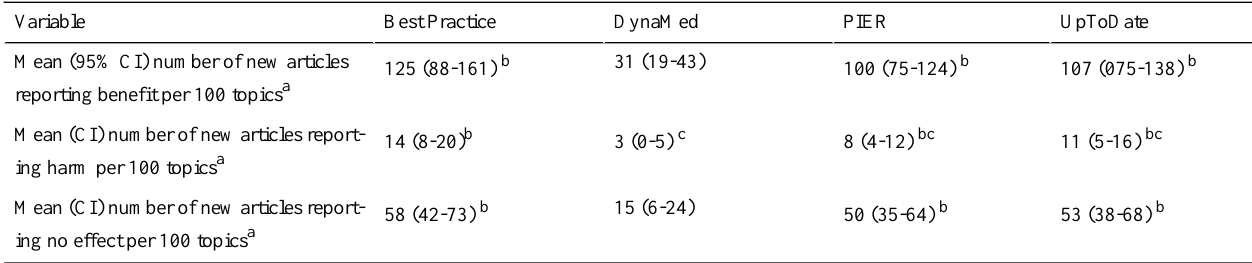
Table 2. Subgroup analysis of articles in PLUS reporting harm, benefit, or no effect. UpToDatePIERDynaMedBest